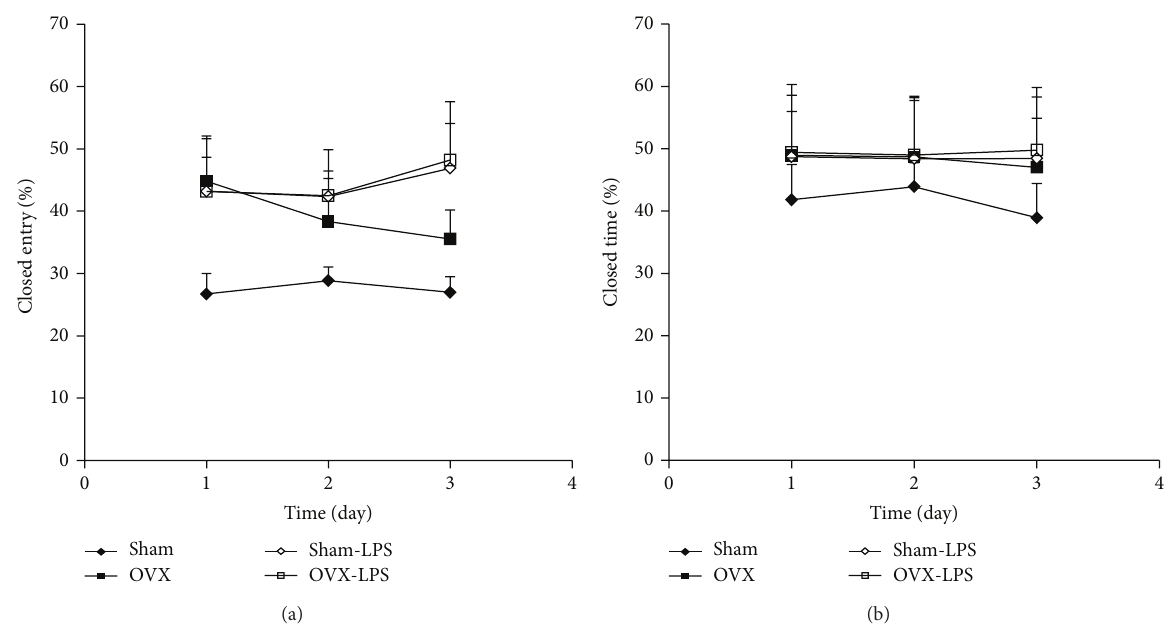
Figure 6: Comparison of the percent number of entries to the closed arm (a) and the percent of time spent in closed arm (b) in the elevated plus maze test between four groups. Data are expressed as mean ± SEM ( 𝑛 = 10 in each group). There were no significant differences between Sham and OVX groups in the percent of entries to the closed arm. The percent of entries to the closed arm by the animals of Sham-LPS group was higher than that of Sham groups ( 𝑃 < 0.01 ). There were no significant differences between four groups in the percent of time spent in the closed